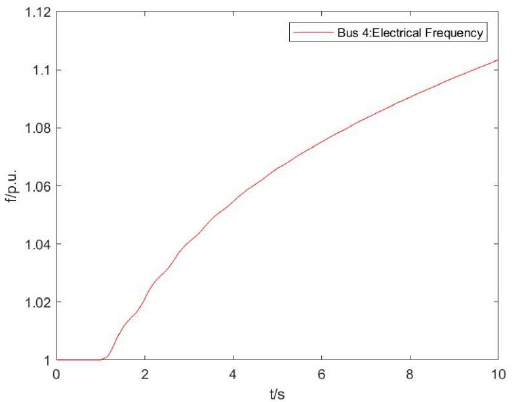
Figure 12. Dynamic response characteristics of frequency (VSG not considered).